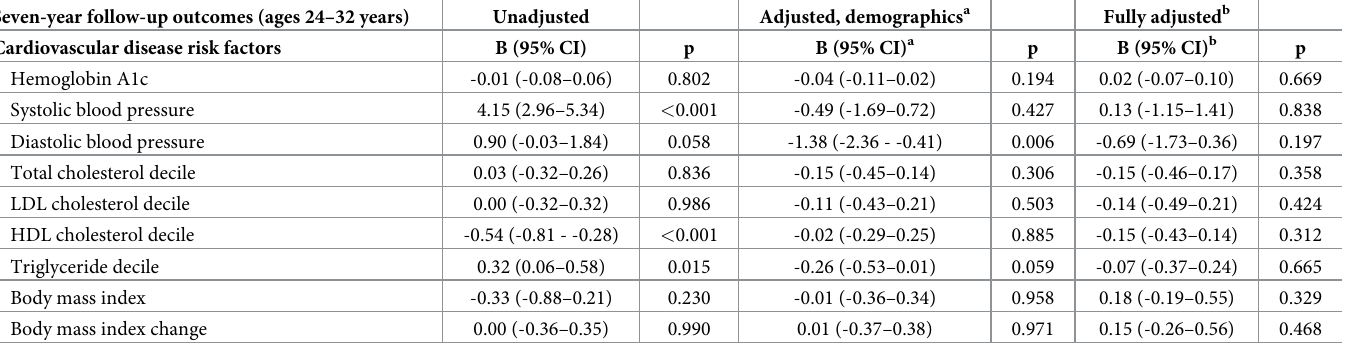
Table 2. Associations between legal performance-enhancing substance use and continuous cardiovascular disease risk factors among young adults at seven-year fol- low-up. Seven-year follow-up outcomes (ages 24–32